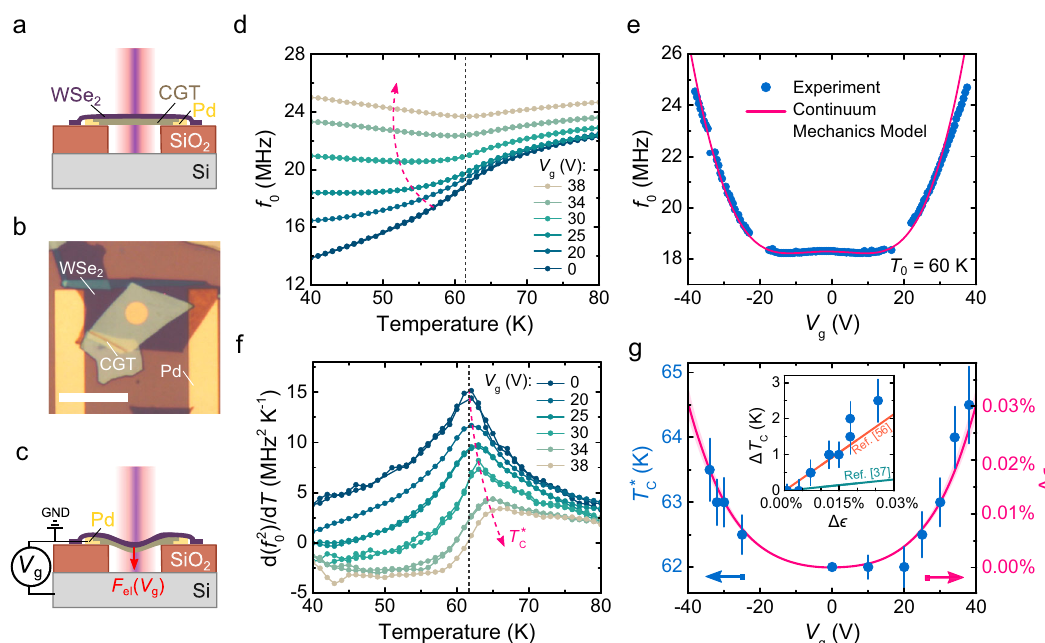
Fig. 5 Curie temperature enhancement as a function of strain in a suspended CGT/WSe 2 heterostructure (19.7 ± 0.1 nm/8.5 ± 0.2 nm). a The schematic cross-section of the suspended CGT/WSe 2 heterostructure membrane. b The optical image of the heterostructure with materials indicated. Membrane radius: r = 2 μ m. Scale bar: 12 μ m. c The schematics of the electrostatic strain-tuning principle. d Measured resonance frequencies f 0 of the heterostructure membrane as a function of temperature for different gate voltages V g . e Filled blue circles — the measured resonance frequency as a function of V g at 60 K. Solid magenta line — the continuum mechanics model fi t 52,53 . f The temperature derivative of f 2 as a function of temperature for different V g . The black vertical dashed lines in ( d ) and ( e ) show the peak position 0 ð Þ 2 0 in d f at V g = 0 V. g Filled blue circles — the shift in measured T (cid:3) as a function of V g extracted from the peak position in (e). Solid magenta line C d T — the estimate of electrostatically induced strain Δ ϵ as a function of V g (see Supplementary Note 3). The shaded magenta region shows the ð V Þ (cid:2) T (cid:3) ð 0V Þ as a function of added voltage induced strain Δ ϵ in addition to calculations from Li uncertainty in Δ ϵ . The inset shows Δ T C ¼ T (cid:3) g C C and Yang 37 (solid green line) and from Dong et al. 56 (solid orange line). The vertical error bars in T (cid:3) were estimated from determining the peak C position in ( e ) within 2% accuracy in the measured voltage V g between the heterostructure membrane and the bottom Si substrate electrode to induce an electrostatic force, F el , that pulls the membrane down and thus strains the CGT/WSe 2 stack. In Fig. 5d, we show the measured f 0 of the heterostructure membrane as a function of temperature for six different values of V g . A notable increase of f 0 as a function of V g is evident which is attributed to the electrostatic strain introduced. To describe the gate dependence of the resonance frequency, we show the f 0 ( V g ) relationship near the phase transition temperature at T 0 = 60 K in Fig. 5e. We fi t the measurement data to a continuum mechanics model of a circular membrane resonator 52,53 (see “ Methods ” ), which describes the experiment well. We thus estimate the electrostatically added strain in CGT layer as: